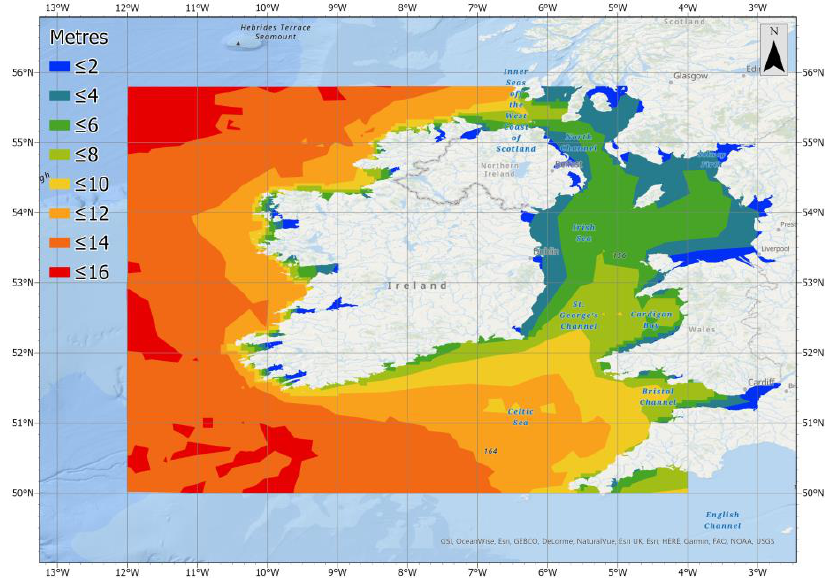
Figure 10. The values in metres for the 50-year return period significant wave